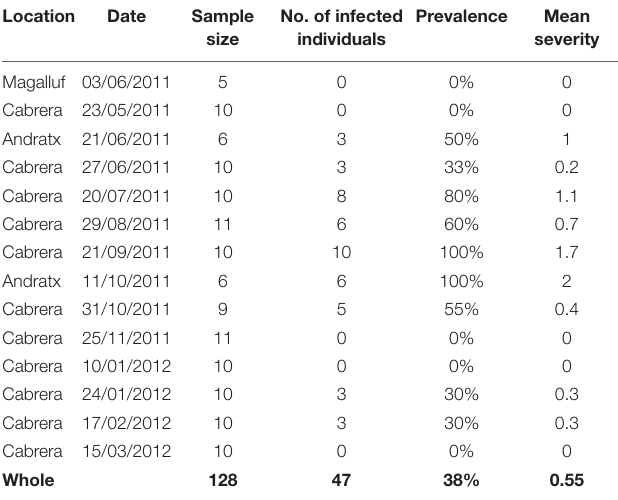
TABLE 4 | Results of RTFM assays for perkinsosis.